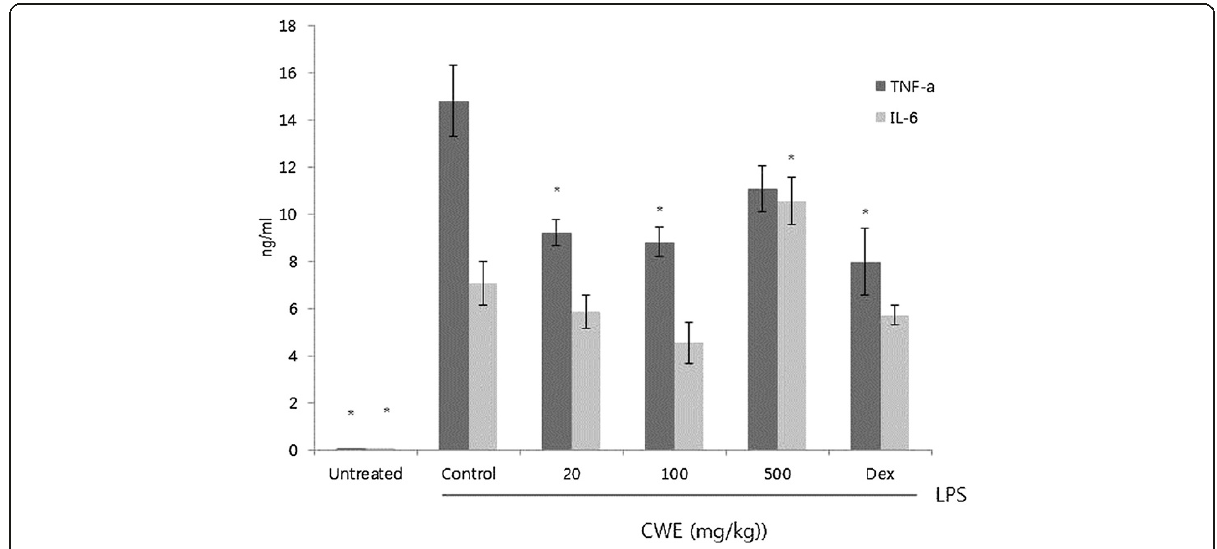
Figure 1 In vivo effect of cinnamon water extract (CWE) on levels of LPS - stimulated serum inflammatory cytokines . CWE (20, 100, and 500 mg/kg) was orally administered to mice for 6 days before intraperitoneal injection of LPS (1.3 mg/kg). Dexamethasone (Dex) (5 mg/kg) was i.p. injected 18 h before LPS injection. Serum was obtained 1 h after LPS stimulation and the levels of TNF- α and IL-6 were measured by ELISA. Data are expressed as the mean ± SEM of three independent experiments (n=12). * P <0.05 compared with the control